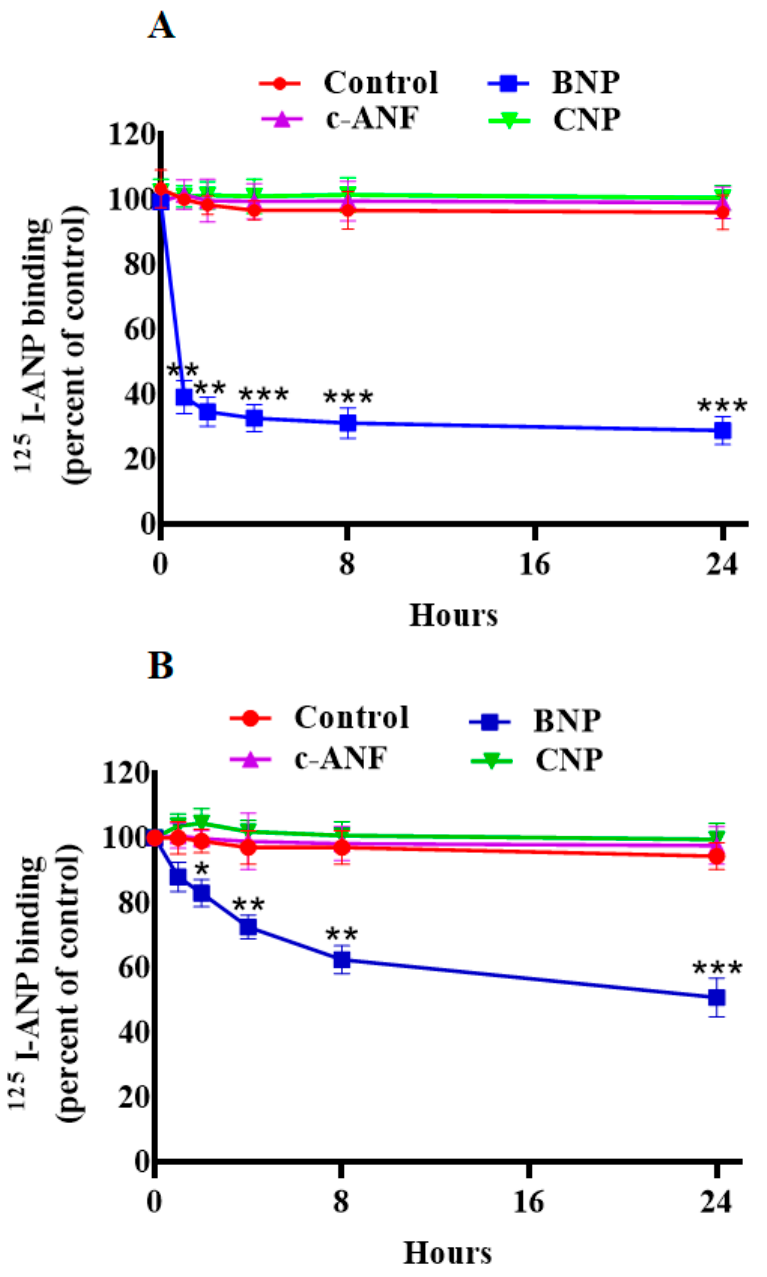
Figure 2. Effect of BNP, c-ANF and CNP pretreatment on 125 I-ANP binding to NPRA in HEK-293 and MA-10 cells. ( A ) Confluent HEK-293 cells and ( B ) MA-10 cells were pretreated with 100 nM of BNP, c-ANF, or CNP for indicated times at 37 °C. Cells were transferred to 4 °C and receptor binding was carried out as described under the section 4. Values represents mean ± SE of 7 independent experiments. * p < 0.05, ** p < 0.01, *** p < 0.001 (untreated vs. drug-treated group).